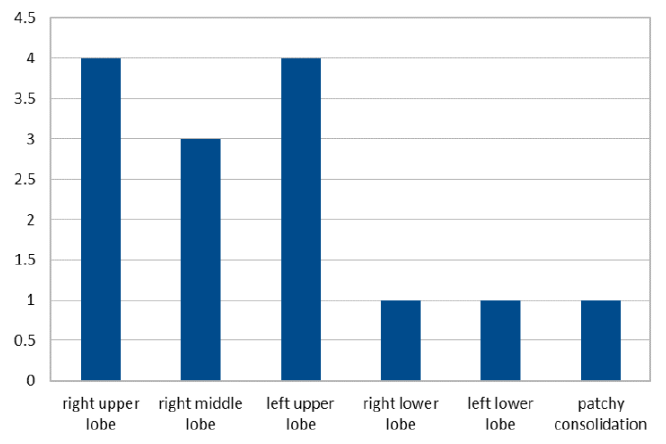
Radiological distribution of